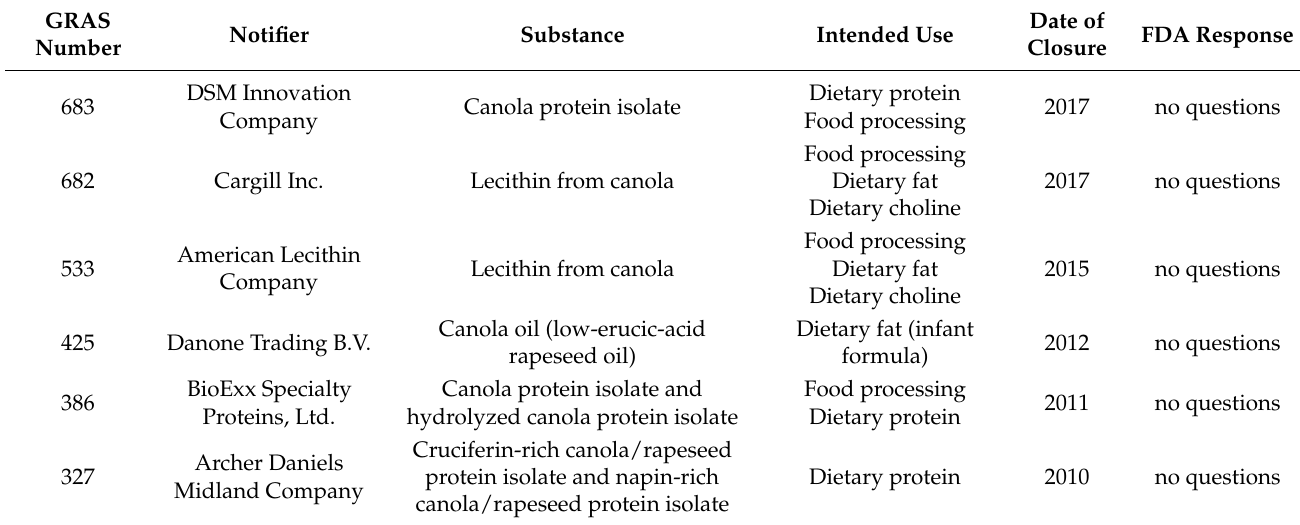
to be safe under its intended use [188]. Table 6. Six canola ( Brassica napus L.) products are listed in the United States Food and Drug Administration’s (FDA) Generally Recognized as Safe (GRAS) notice inventory since the inventory was established in 1998. In all applications, the FDA had no questions regarding the GRAS status of the product. Current as of September